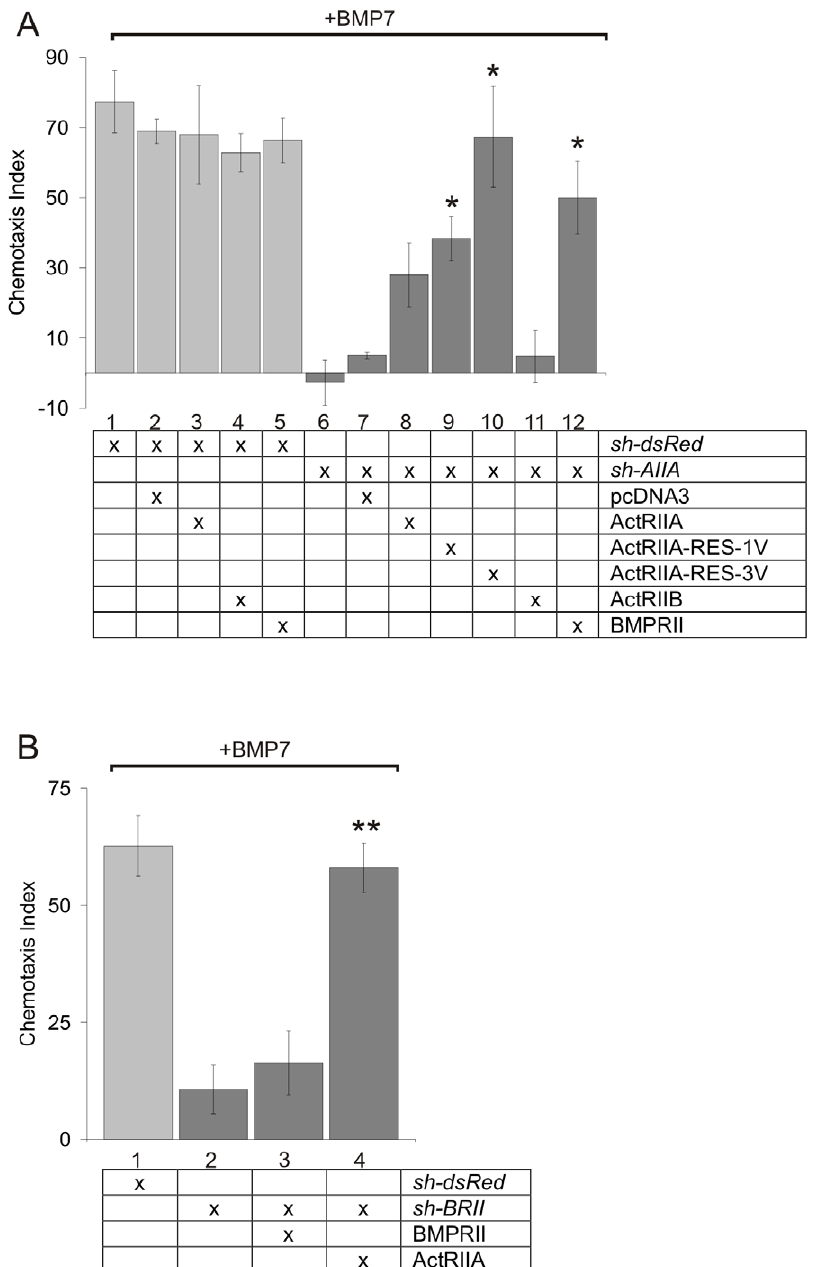
Figure 5. Rescue of shRNA-mediated inhibition of BMP7-stimulated chemotaxis by ActRIIA and BMPRII but not ActRIIB. A: Chemotaxis in response to 10 pg/ml BMP7 (mean + / 2 SEM) of dsRed D WEHI cells (Lanes 1–5): alone (CI=77 + / 2 9, n=3) or co-expressing pcDNA3 (CI=69 + / 2 4, n=2), ActRIIA (CI=68 + / 2 14, n=3), ActRIIB (CI=63 + / 2 5, n=2) or BMPRII (CI=66 + / 2 6, n=2). These are compared with ActRIIA D WEHI cells (Lane 6–12): alone (CI= 2 3 + / 2 6, n=3) or co-expressing pcDNA3 (CI=5 + / 2 1, n=3), wild-type ActRIIA (CI=28 + / 2 9, n=3), ActRIIA-RES-1V (CI=38 + / 2 6, n=3), ActRIIA-RES-3V (CI=67 + / 2 14, n=3), ActRIIB (CI=5 + / 2 8, n=3) or BMPRII (CI=50 + / 2 10, n=3). B: Chemotaxis in response to 10 pg/ml BMP7 (mean + / 2 SEM) of dsRed D WEHI (CI=63 + / 2 7) and BMPRII D WEHI (CI=11 + / 2 5) cells (Lanes 1 and 2) compared with BMPRII D WEHI cells co-expressing wild-type BMPRII (CI=16 + / 2 7) or ActRIIA (CI=58 + / 2 5) (Lanes 3 and 4). n=3 for each condition. BMP7-evoked chemotaxis in ActRIIA D WEHI cells expressing ActRIIA-RES-1V, ActRIIA-RES-3V or BMPRII differs significantly from chemotaxis in ActRIIA D WEHI cells alone; (*) p , 0.02 (Student’s t test). BMP7-evoked chemotaxis in BMPRII D WEHI cells expressing wild-type ActRIIA differs significantly from chemotaxis in BMPRII D WEHI cells alone; (**) p , 0.005 (Student’s t